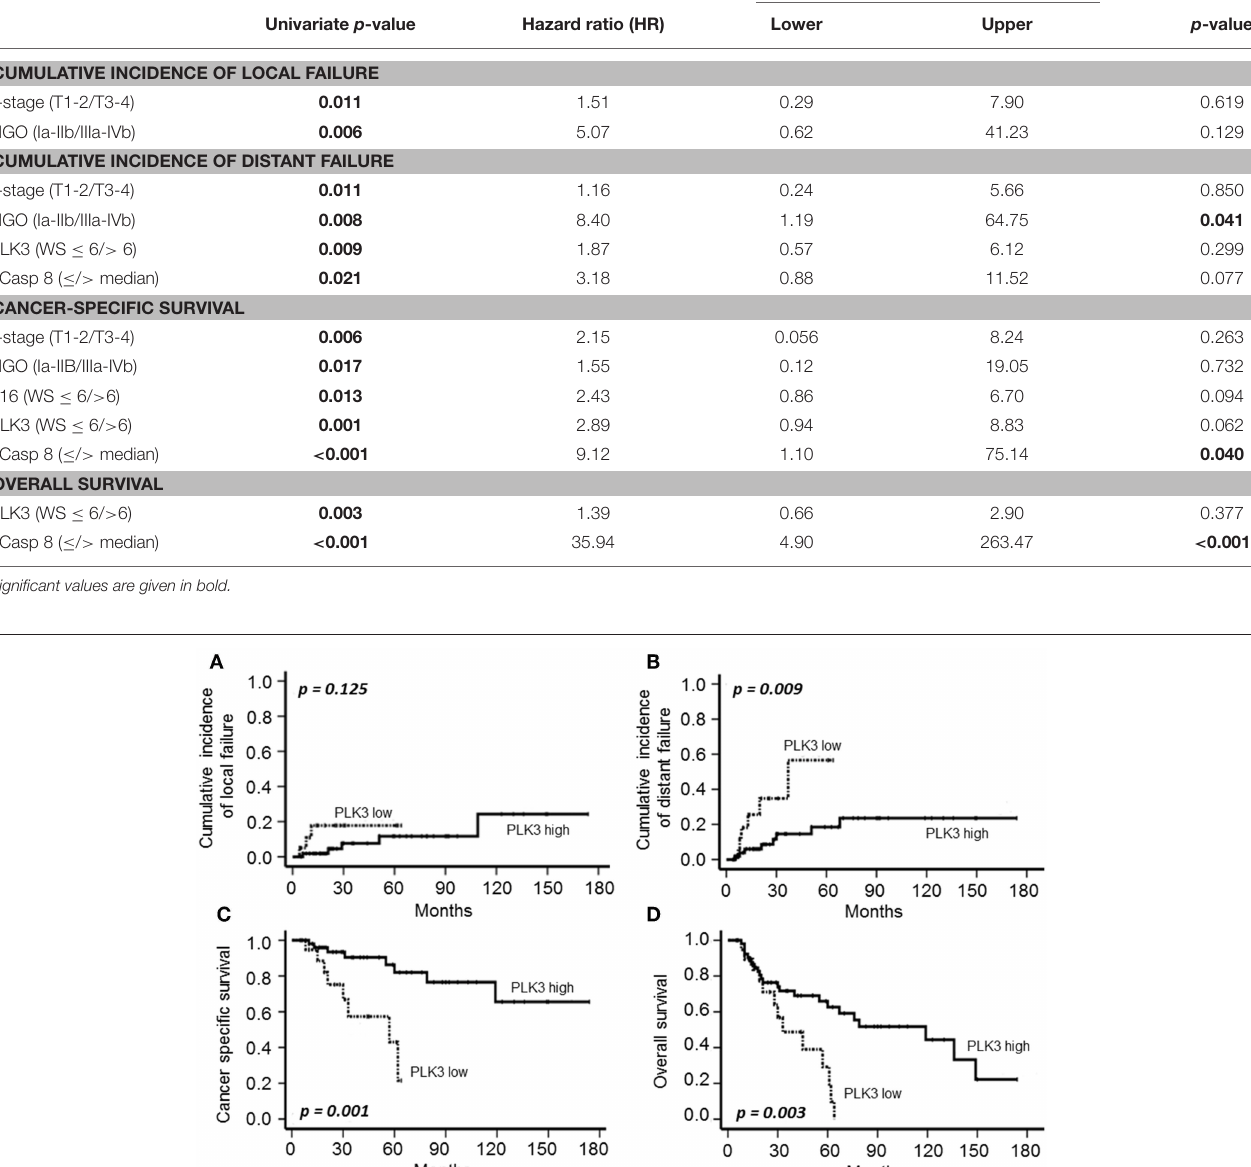
TABLE 3 | Univariate and multivariate analyses of prognostic factors in patients with CSCC. Univariate p